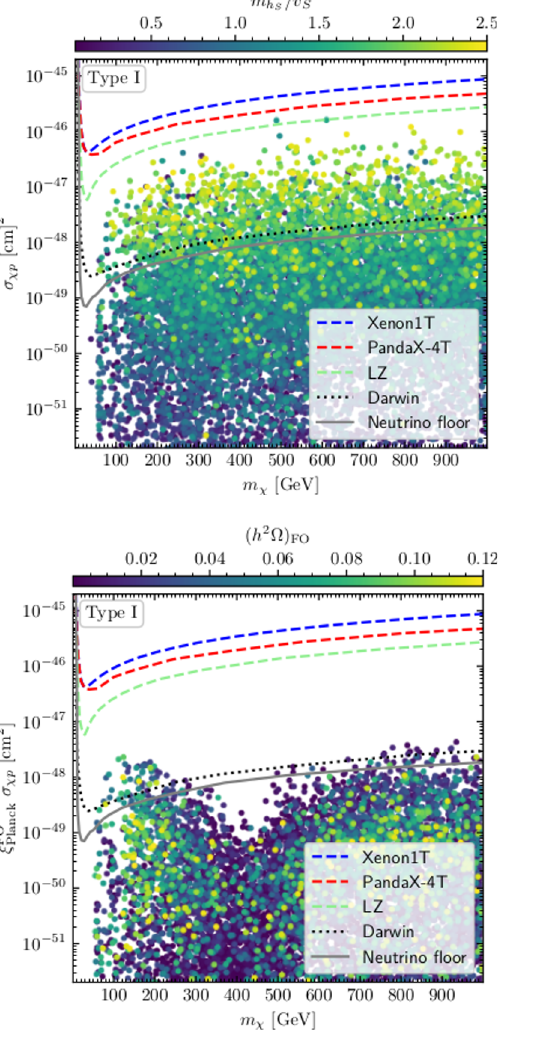
Figure 9 . Parameter points of the scan in type I (left) and type I (right) in the ( m χ , σ χp ) plane (top) and in the ( m χ , ξ FO σ χp ) plane (bottom). The color coding of the points indicates the value Planck of m h /v S (top) and the value of ( h 2 Ω) FO (bottom). Also shown are the current upper limits on S the 95% confidence level from XENON1T [3] (blue dashed line), from PandaX-4T [2] (red dashed line) and from LZ [4] (dashed green line), and the projected upper limit from Darwin [36] (dotted line). The gray solid line indicates the neutrino floor